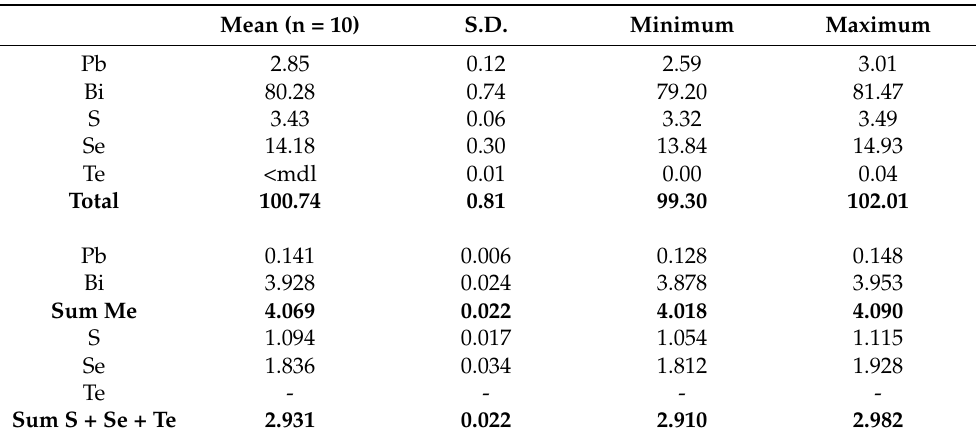
Table 2. Electron probe microanalysis data for laitakarite (wt.%).